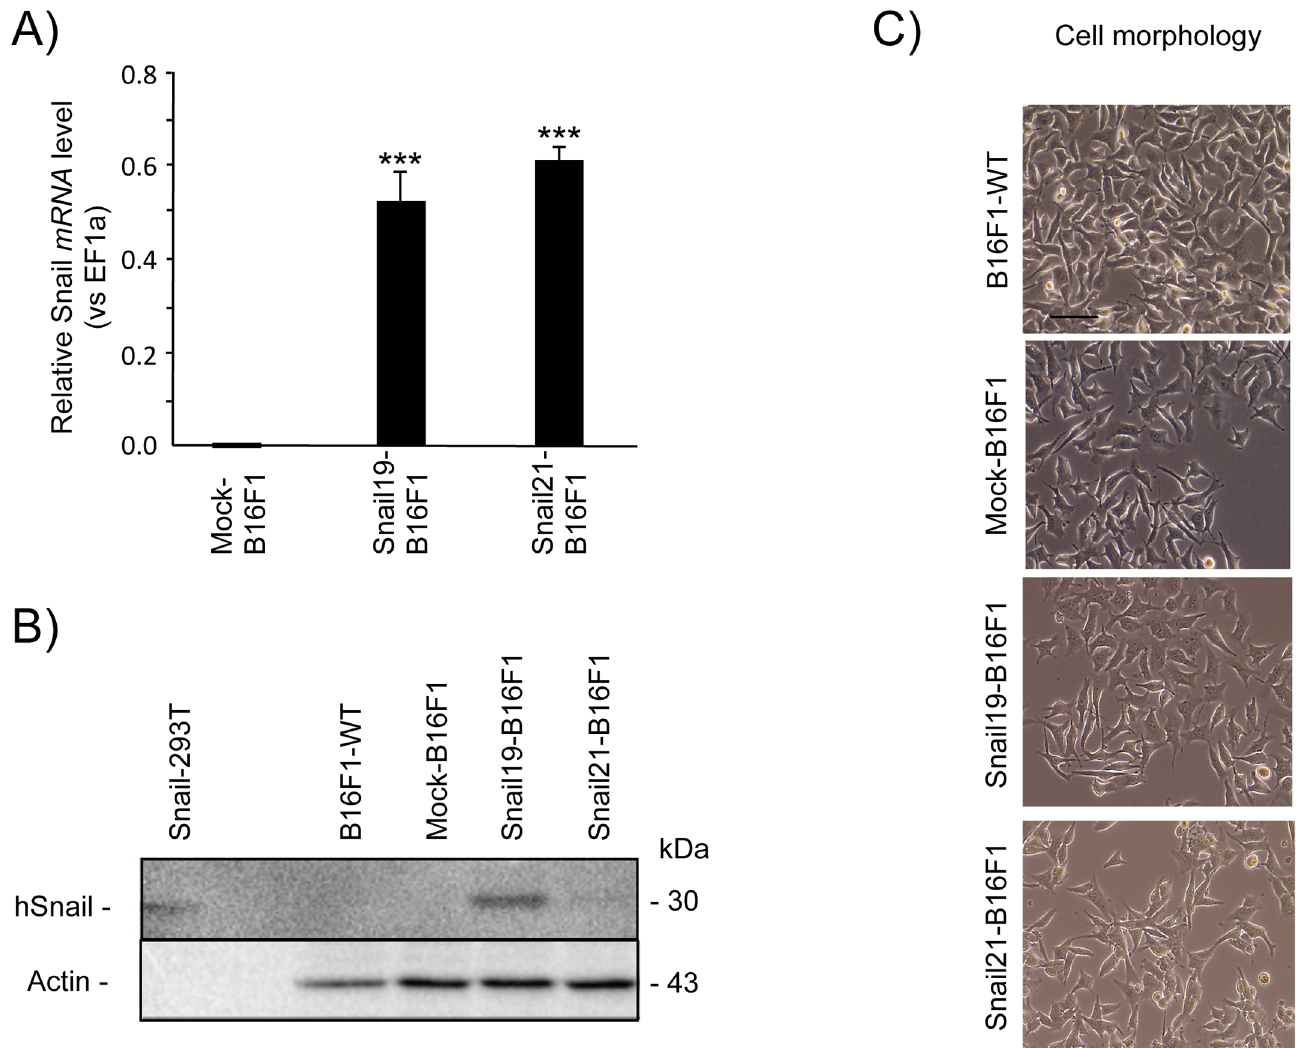
Fig 1. Characterization of Snail-B16F1 stable clones. Quantitative RT-PCR analysis of human snail ( SNAIL ) mRNA levels normalized to EF1a . Mean ± SD, n = 4, *** p < 0.001. (B) Western blot analysis of Snail in B16F1-WT, in mock-B16F1 and in Snail overexpressing B16F1 cells (clones Snail19-B16F1 — high expression of Snail and Snail21-B16F1 — low expression of Snail). (C) Morphology (representative pictures) of B16F1-WT, mock-B16F1, and Snail- overexpressing B16F1 cells as observed by phase contrast microscopy (scale bar, 10 μ